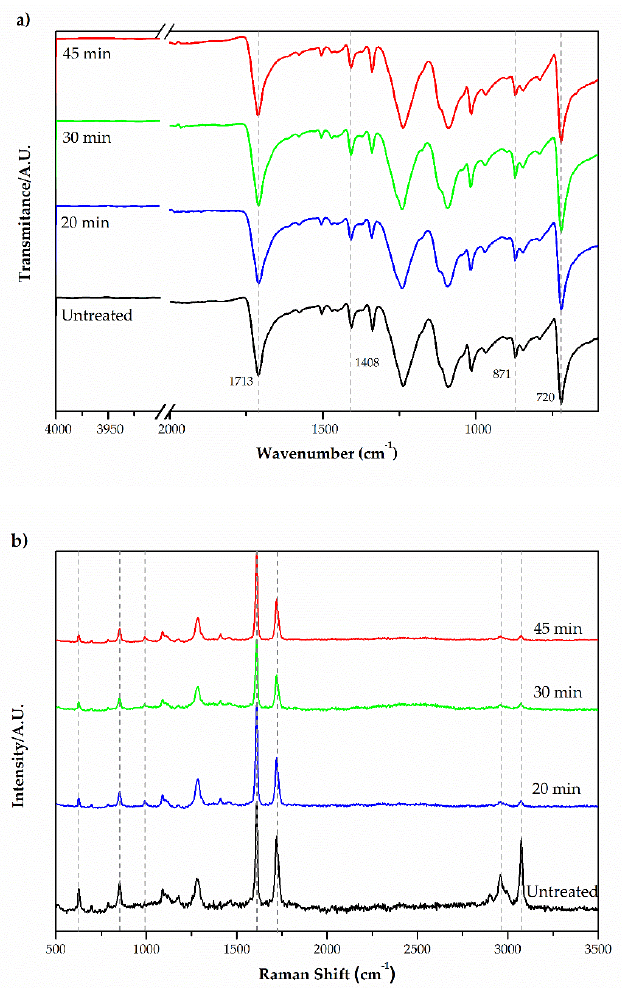
Figure 1. ( a ) FTIR-ATR spectra and ( b ) Raman spectra of polyester fabric samples with and without treatment at different time.